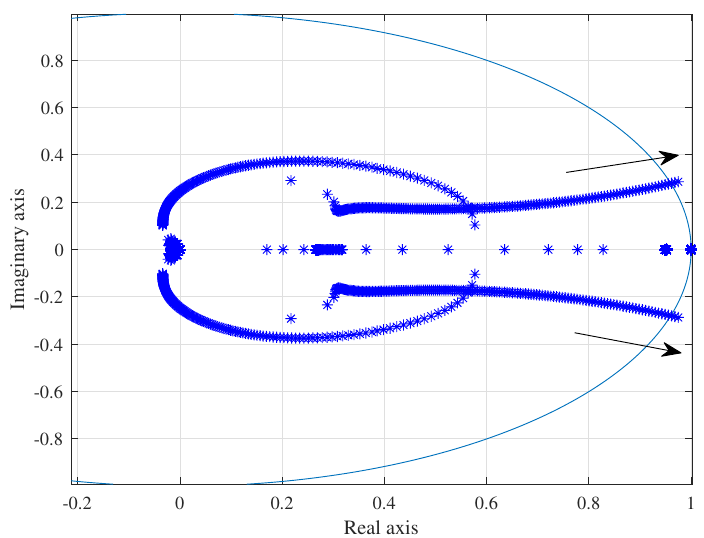
Figure 5. Floquet multipliers result from the variation K q = 0.002, K p = [ 3 × 10 − 5 : 0.0025 ] .